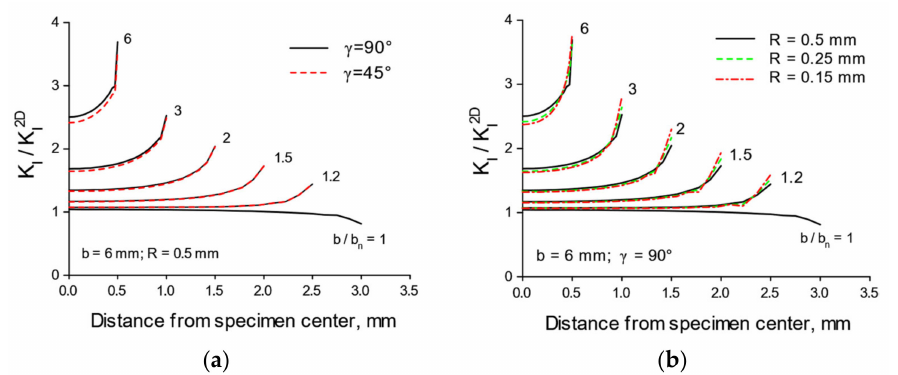
Figure A3. Stress intensity factor distribution along the crack front for grooves of different depths and two angles ( a ) and different radii at the tip of the groove ( b ). Numerical results are normalized by a two-dimensional solution.